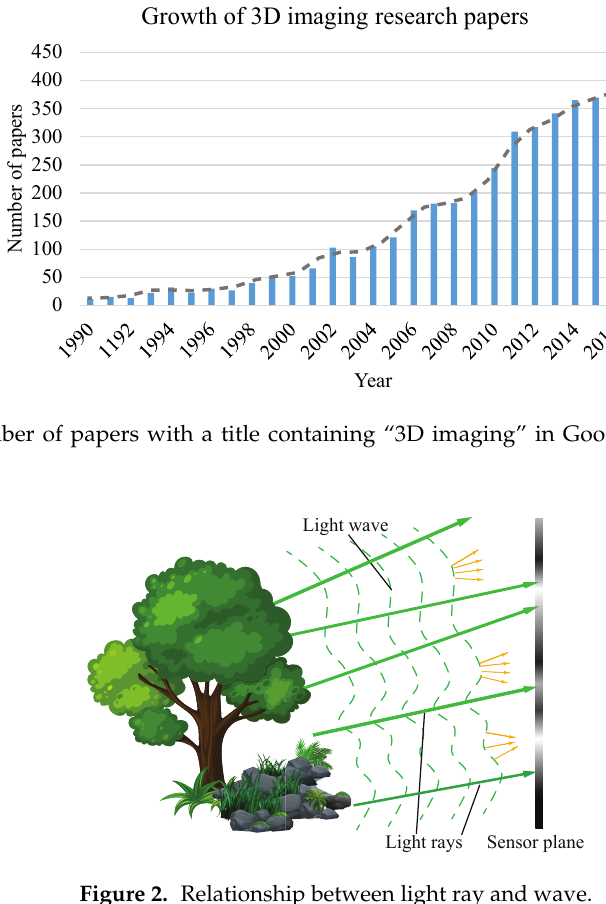
Figure 2. Relationship between light ray and